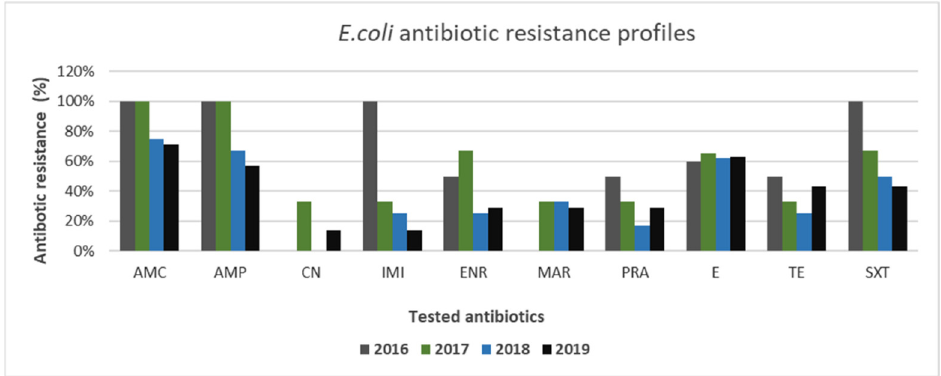
Figure 9. Antimicrobial resistance profiles of canine E. coli strains to commonly used antibiotics.